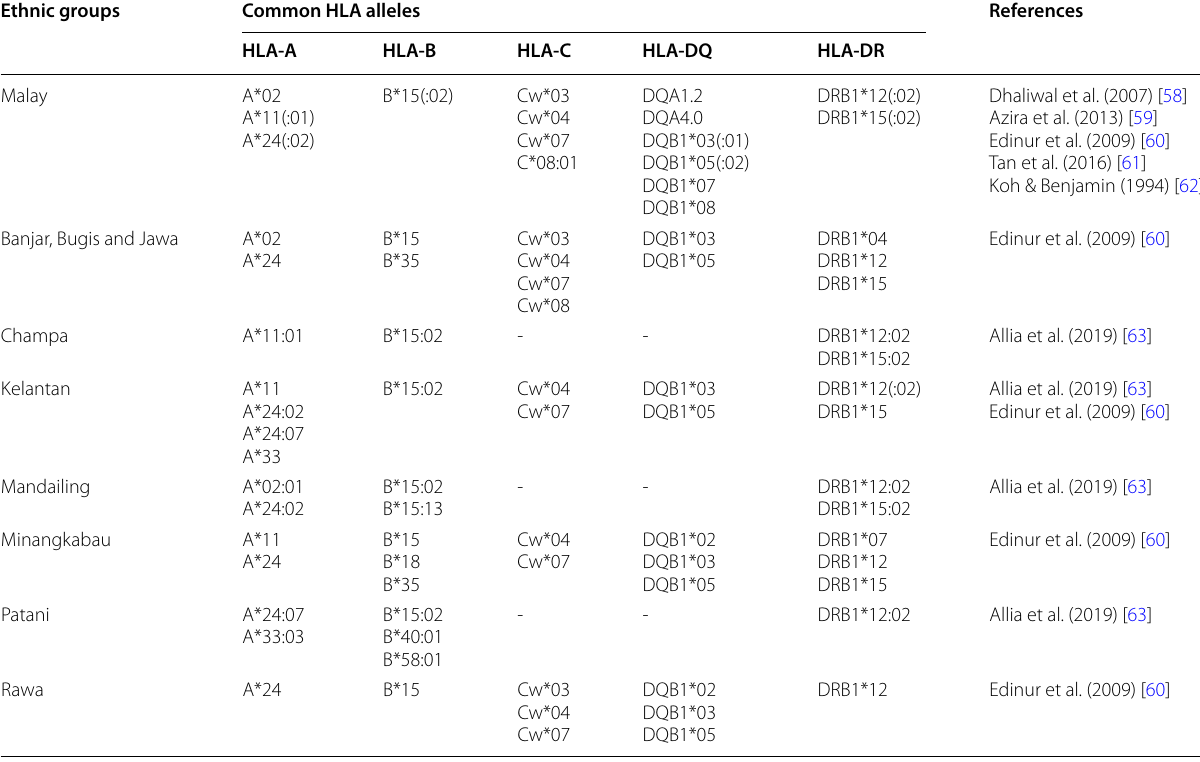
Table 3 Common HLA alleles among Malays and their sub-ethnic groups in Malaysia Ethnic groups Common HLA